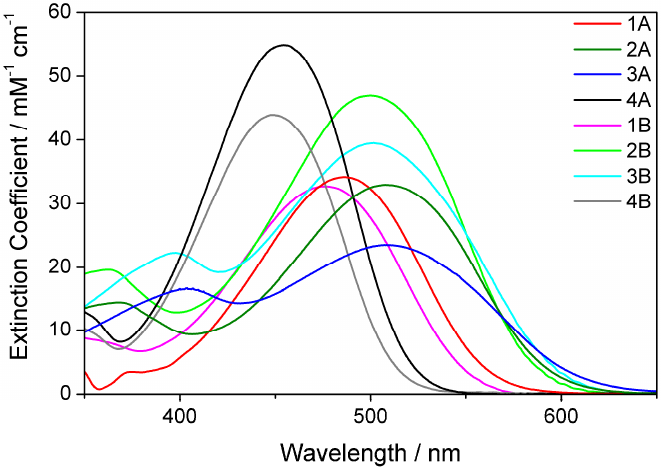
Figure 3 . Experimentally collected electronic absorbance spectra for studied compounds, as recorded in DCM.